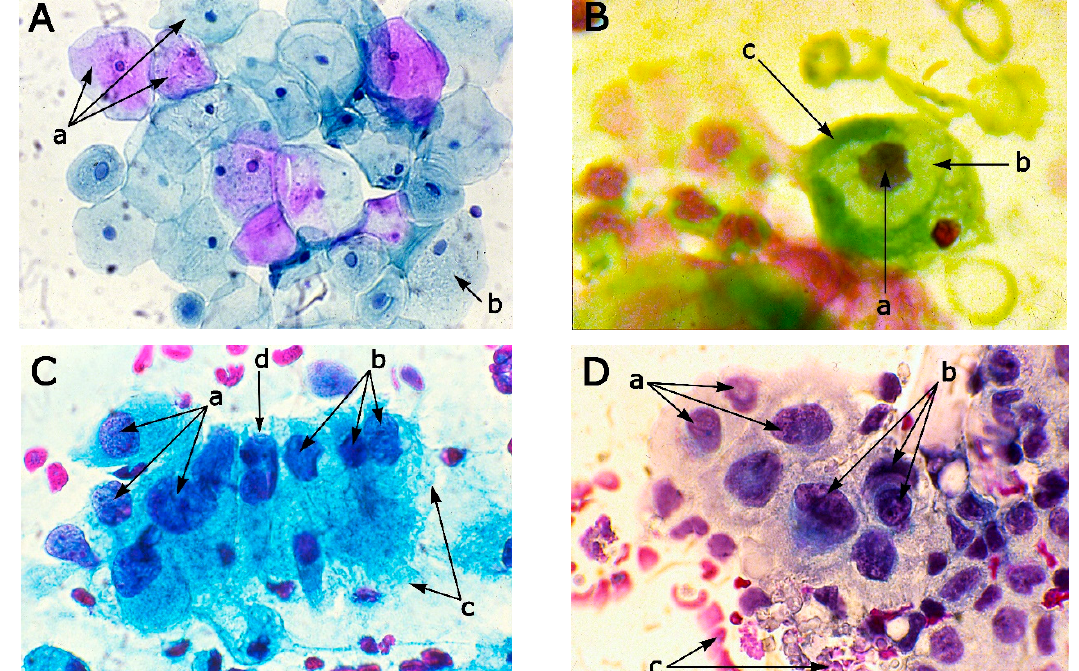
Figure 3. Cellular morphological disorder indicates pathologically mutated forces. ( A ) Healthy uterine cervix cells: (a) superficial squamous cells. (b) Intermedial cells. ( B ) LSIL—low grade squamous intraepithelial cervical cell lesion (mild precancerosis): (a) nucleoli are generally absent, nuclei are three times larger compared to those of normal intermedial cells. A variable degree of nuclear hyperchromasia. (b) Perinuclear cavitation (koilocytosis) consisting of sharply delineated clear perinuclear zone. (c) Well-defined cytoplasm. ( C ) HSIL—high grade squamous intraepithelial cervical cell lesion (severe precancerosis): (a) the cells are smaller than the cells in LSIL. Cell size varies. (b) The degree of nuclear enlargement is variable too. (c) Contours of nuclear membrane are quite irregular. (d) Wrinkling of nuclear membrane. ( D ) Invasive carcinoma cells: (a) cells are frequently smaller than healthy ones and display most of the features of HSIL cells. (b) Nuclei demonstrate coarsely clumped chromatin. (c) Tumor diathesis consists of necrotic debris of cells and old blood. Magnification: ( A ) 200×; ( B – D ) 350×; Staining: ( A , C , D )—Papanicolaou [69], ( B )—Pekárek [70], Kobilková and Siracký [71]. Location: ( A ) ectocervix of uterus; ( B ) vagina; ( C , D ) endocervical area. Nuclei—dark colors; cytoplasm—light colors.